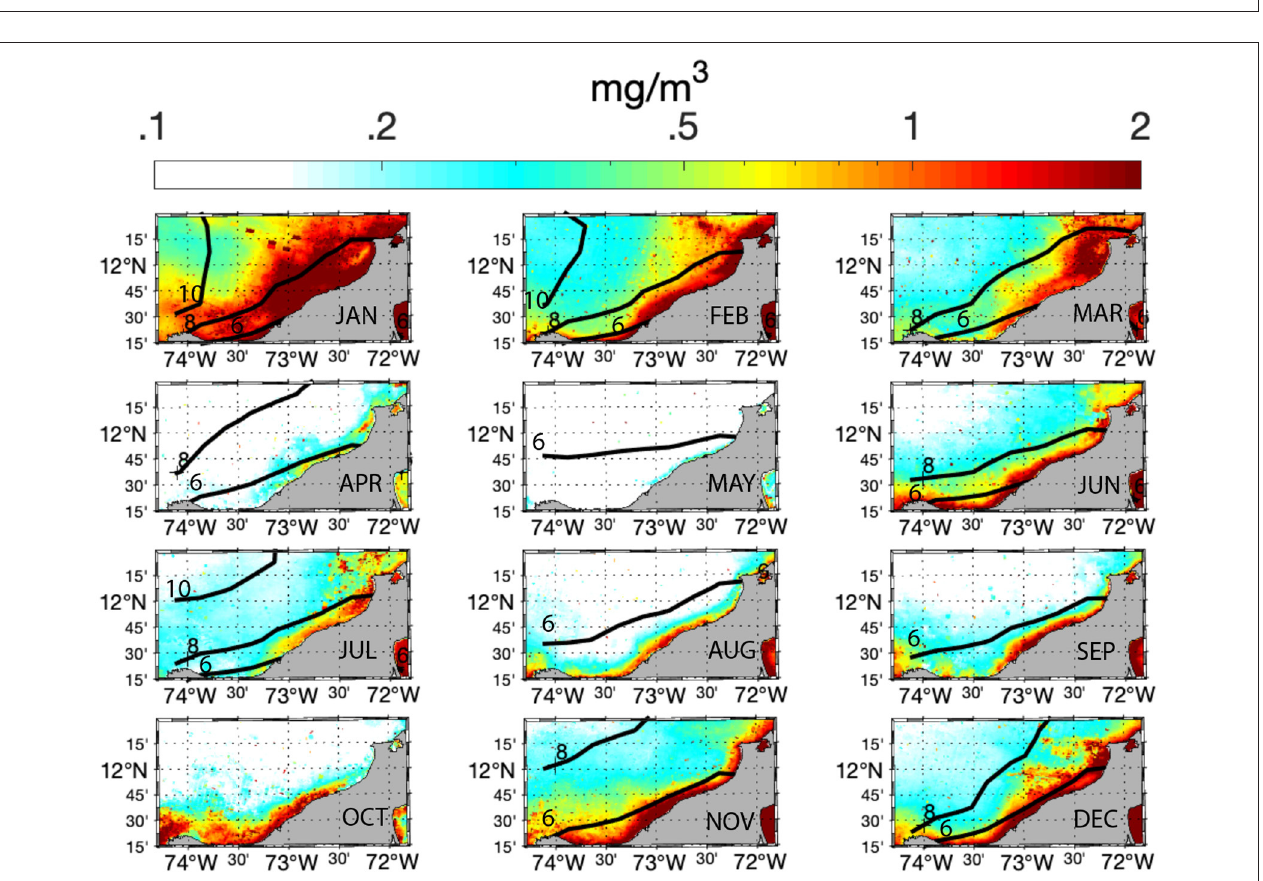
FIGURE 4 | Monthly averaged chlorophyll-a (Chl-a) for La Guajira region for years 2007 and 2008. Black lines indicate the 6, 8, and 10 m · s − 1 isolines of surface wind speed. During October wind contours are below the 6 m · s − 1 in the area of study.